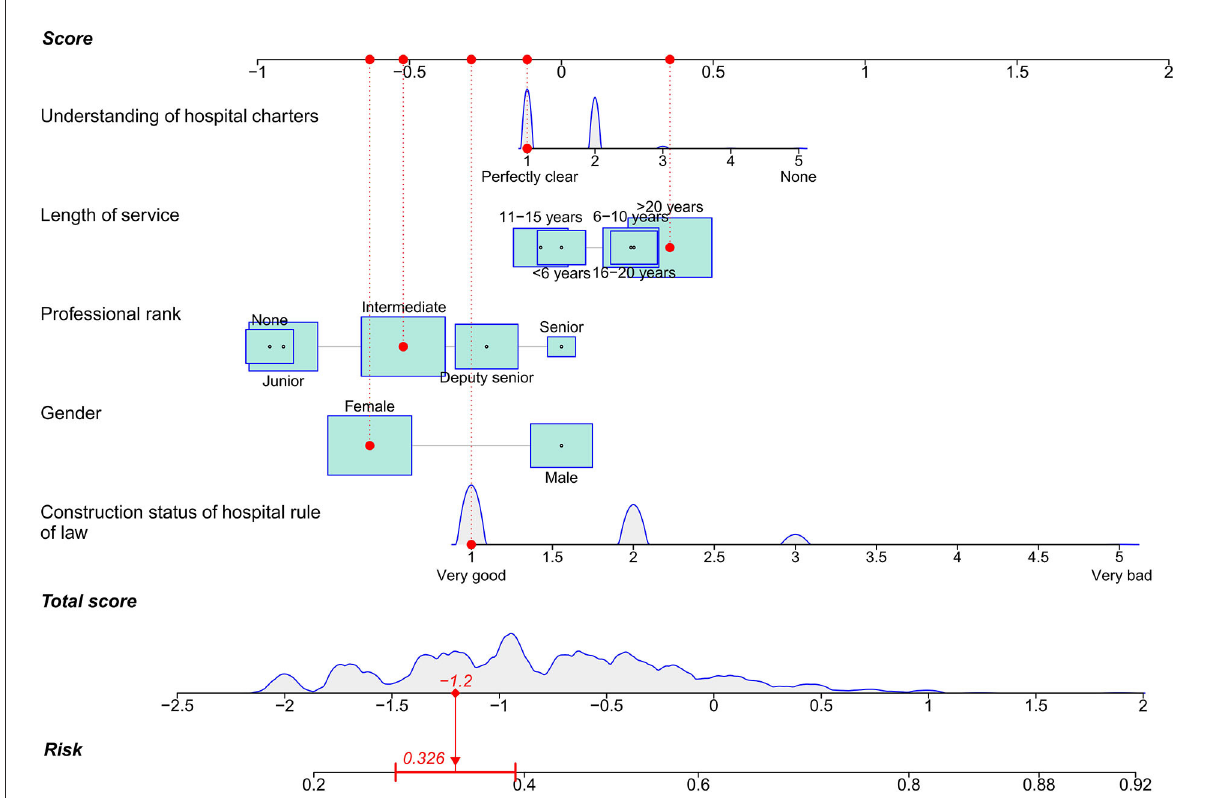
FIGURE3 Nomogram to predict the likelihood of medical disputes. An illustration of using the nomogram is provided: Each feature can obtain a score by referring to score axis, and the total score is the sum of all the features. The final risk probability of medical disputes can be determined by referring to risk axis from overall score axis. Continuous features are presented as density curve, and proportion features are depicted as boxes, with larger boxes denoting higher